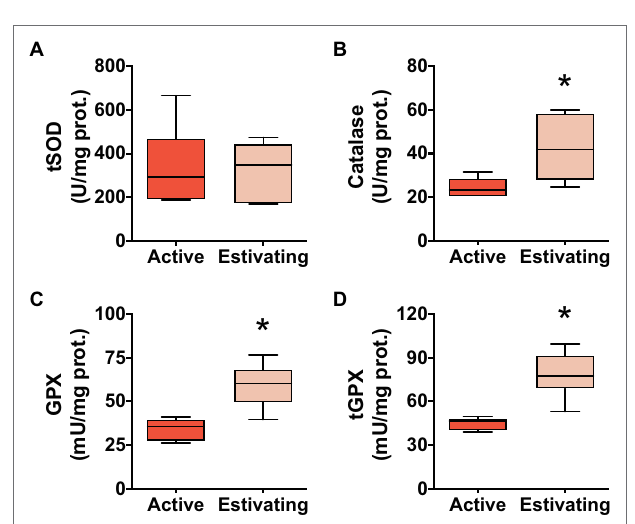
FIGURE 5 | Activities of core antioxidant enzymes in the skeletal muscle of Pleurodema diplolister collected during the dry season (estivating) or the rainy season (active). (A) Total superoxide dismutase (tSOD). (B) Catalase. (C) H 2 O 2 -Glutathione peroxidase (GPX). (D) Total glutathione peroxidase (tGPX). The asterisk (*) denotes significant differences between active and estivating groups. N =